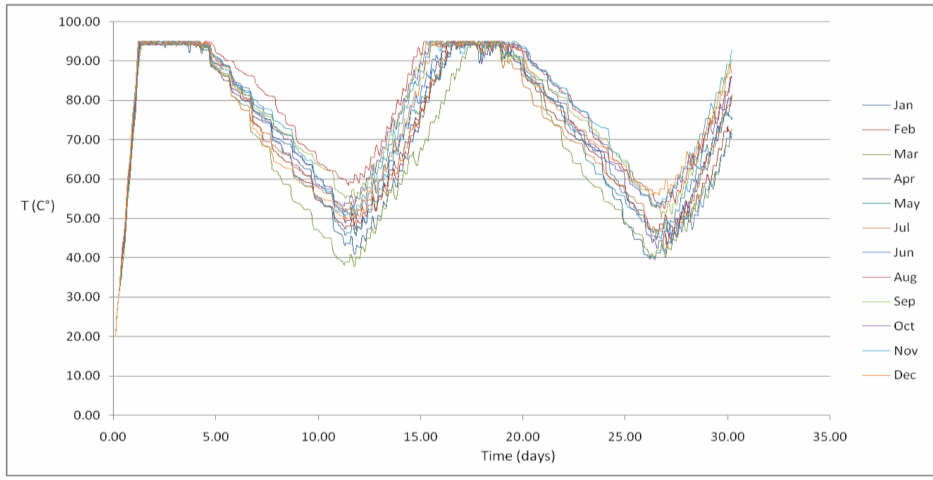
Figure 15. Temperature in 10 m 3 HWT for energy demand for 10 families (Case